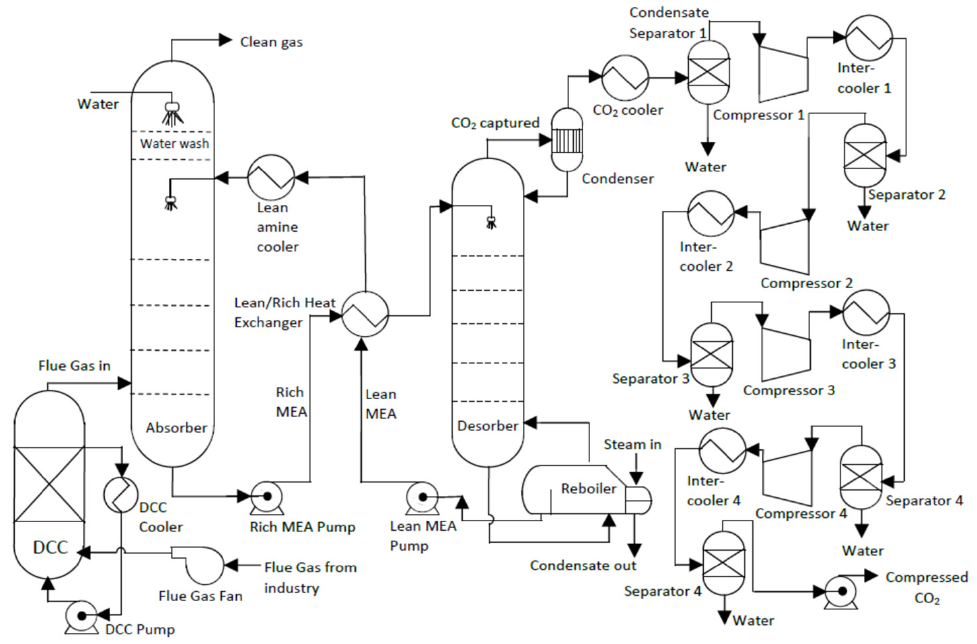
Figure 1. Standard CO 2 capture process [3].